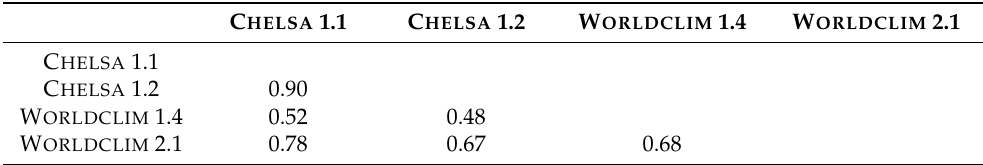
Table 3. Spearman rank correlation coefficients of Mean Temperature of the Wettest Quarter for all climate datasets and respective versions. All correlations were highly significant ( p ≤ 0.001).